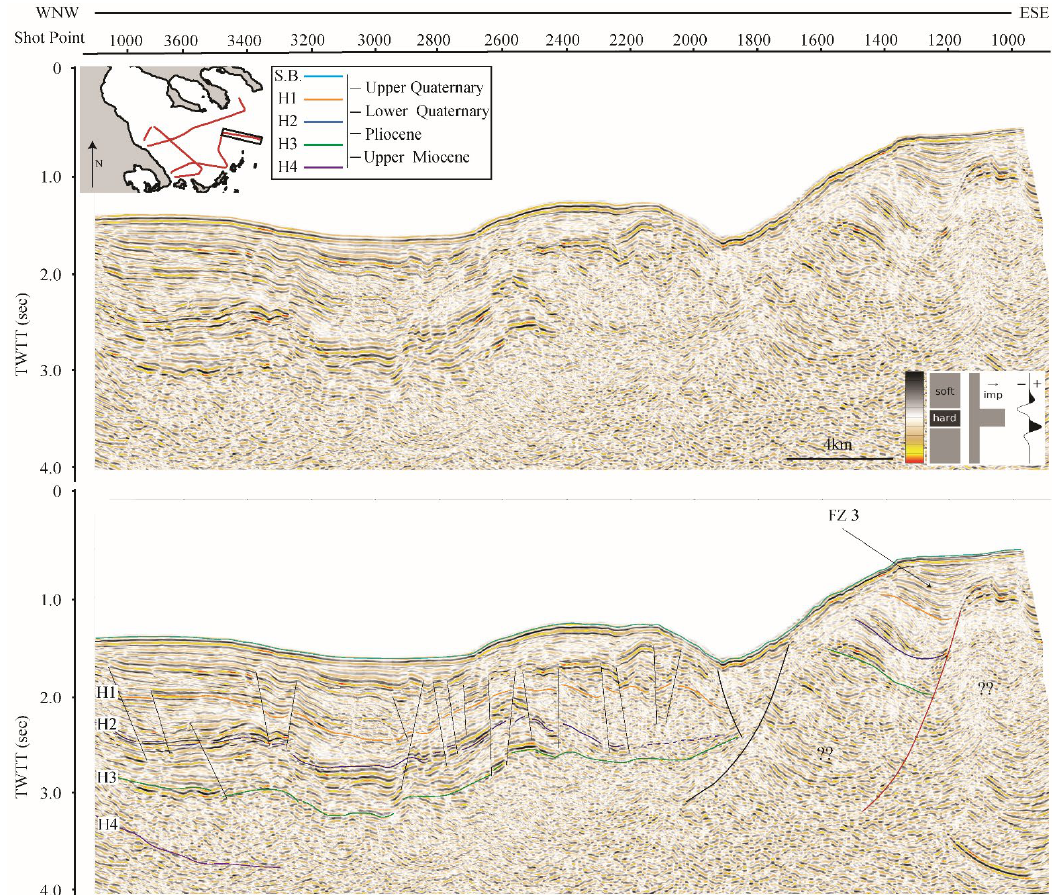
Figure 13. Seismic Line AB. Upper part: un-interpreted set of regional seismic profiles. Lower part: interpreted seismic section with highlighted key horizons and the most prominent tectonic elements.